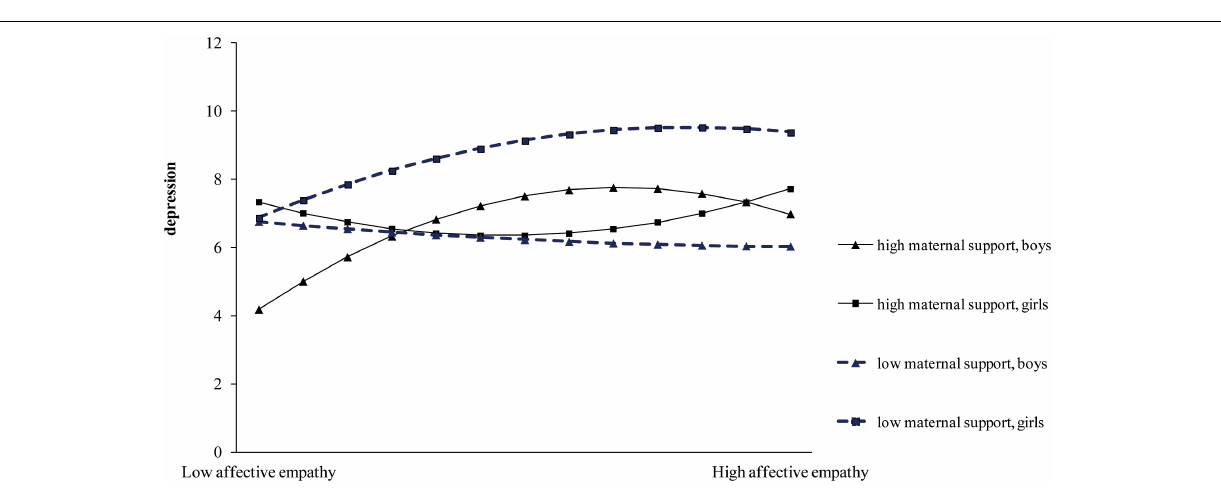
FIGURE 2 | Moderating effect of maternal support and gender on the curvilinear relationship between affective empathy and